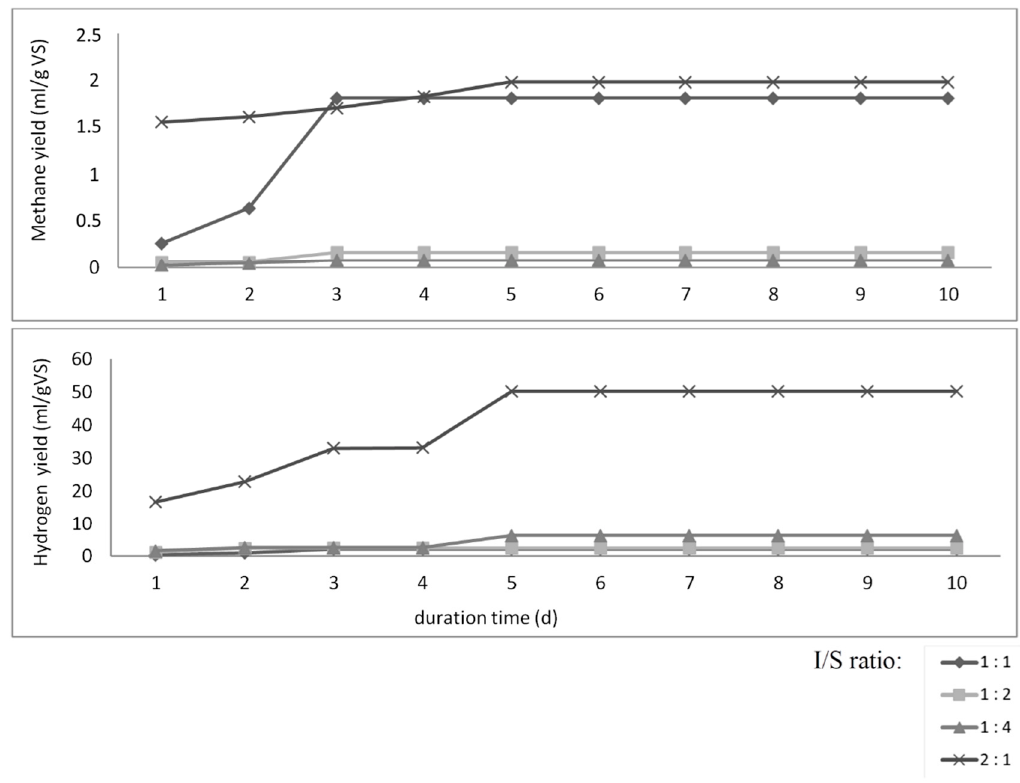
Figure 4. Cumulative methane and hydrogen productions during hyperthermophilic treatment of grass at 70 °C.